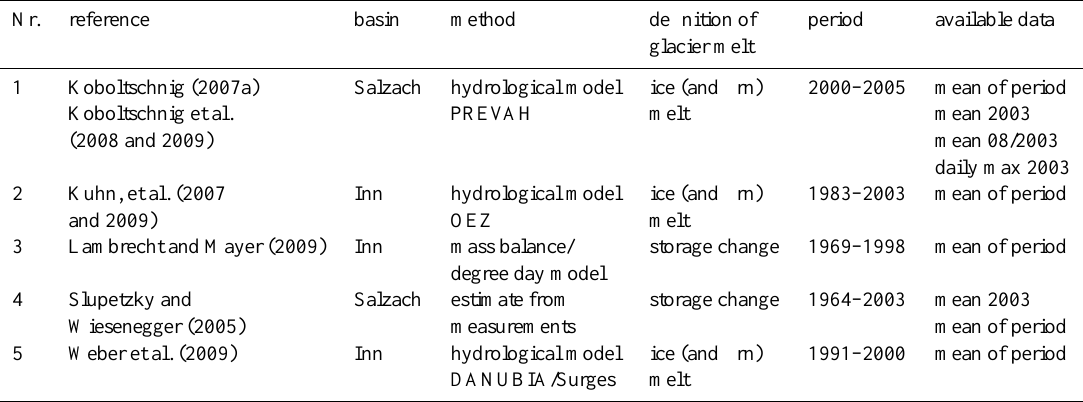
Table 1. Data source of available glacier melt contribution values for the Inn (Danube) and Salzach basin including the calculation method, the definition of glacier melt and calculation